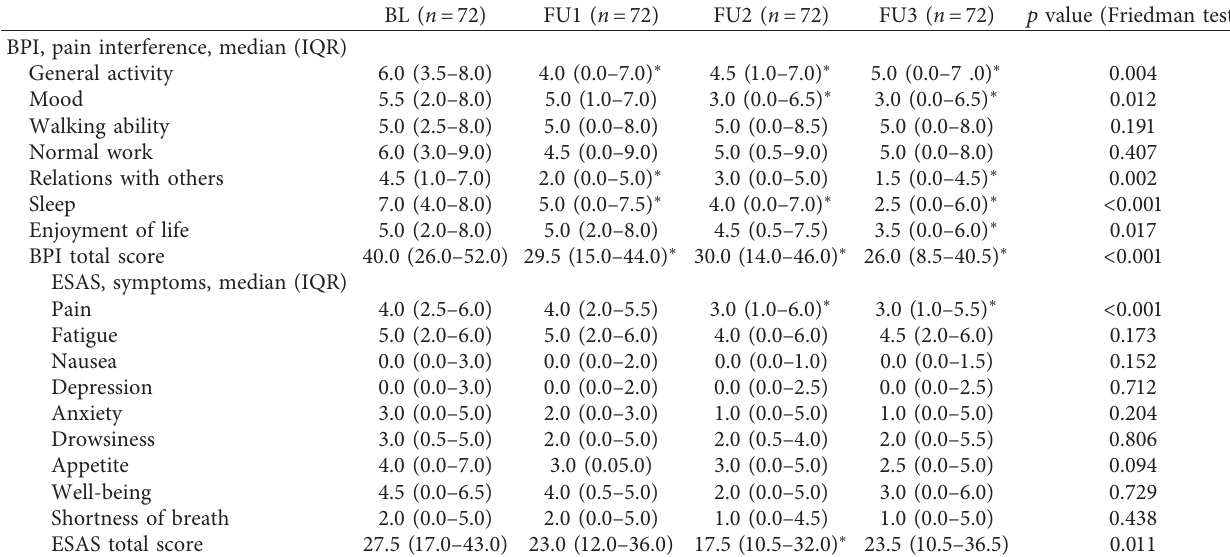
Table 3: Pain interference rating by BPI and other symptoms’ rating per ESAS.